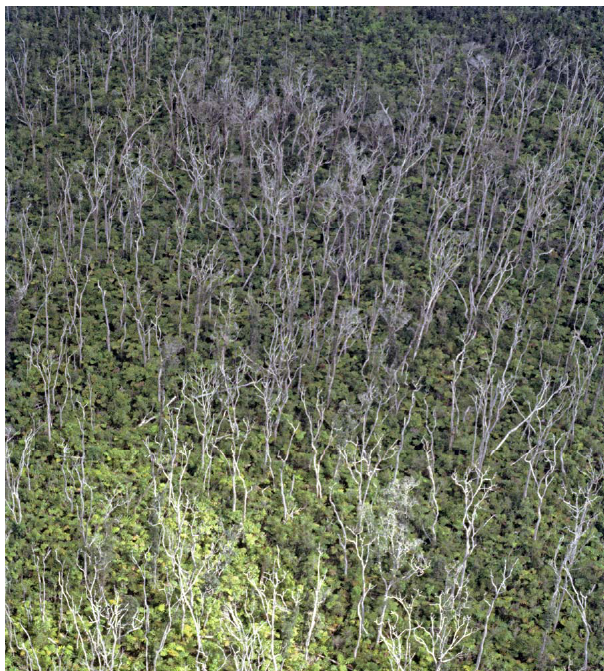
Fig. 6. View from helicopter (of same dieback area as shown on Fig. 5) clearly shows the cohort stand structure of the canopy tree ‘ ō hi‘a lehua ( Metrosideros polymorpha ). Note the healthy undergrowth of mostly hapu‘u ( Cibotium sp. ) tree ferns (photo by James D. Jacobi, 1976).